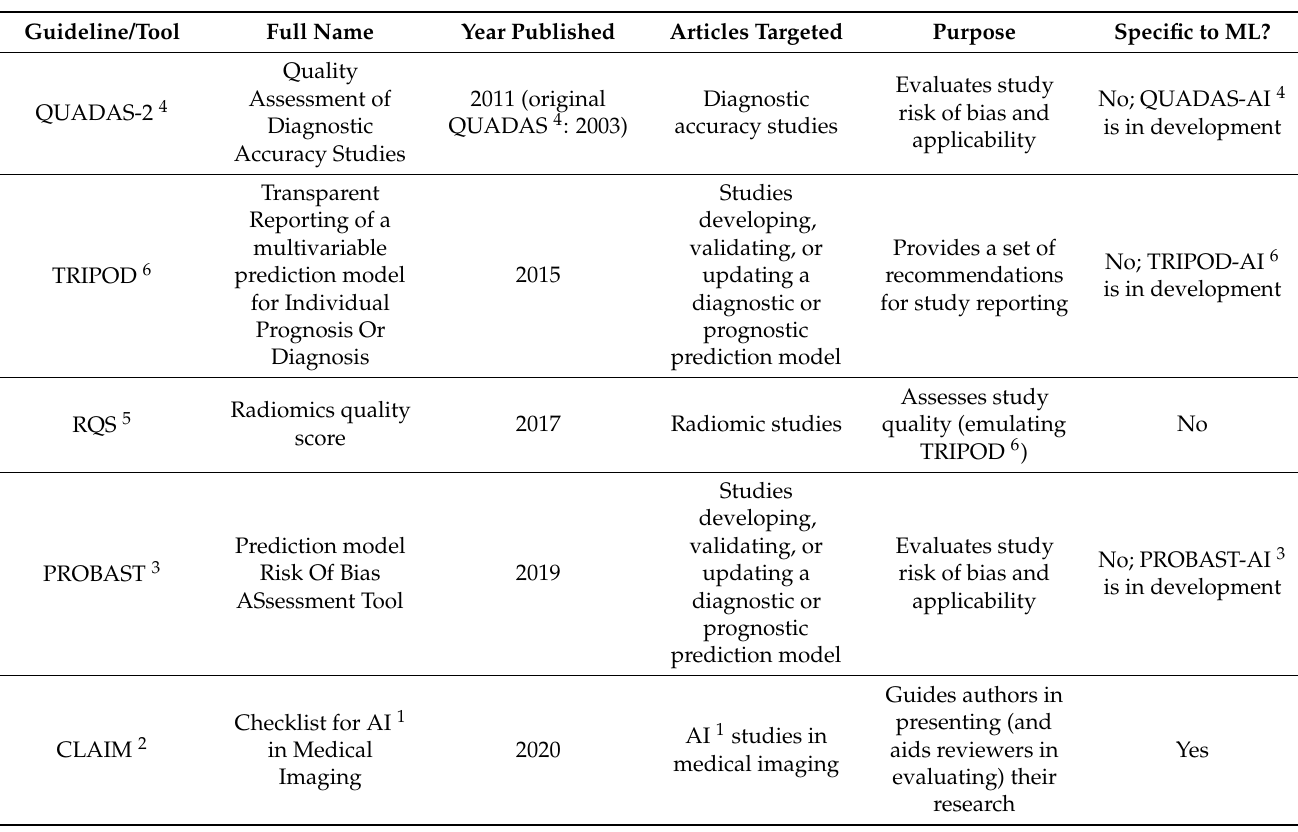
Table 2. Overview of major reporting guidelines and bias assessment tools for diagnostic and prognostic